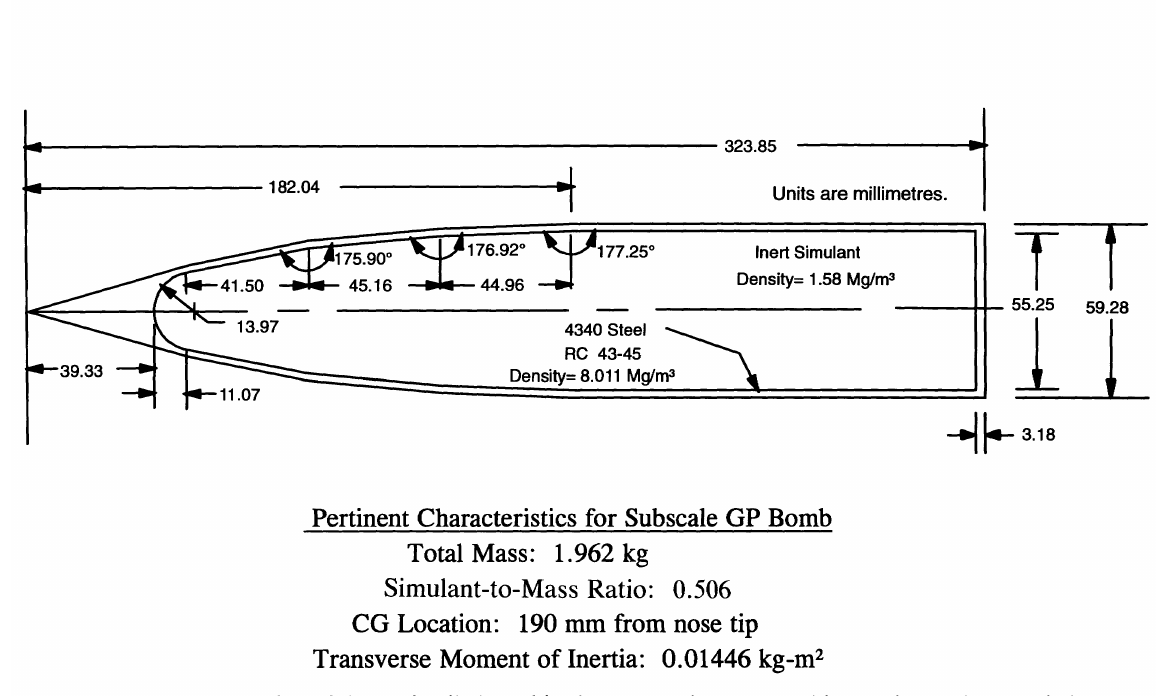
FIGURE 1 Drawing of the projectiled used in the penetration tests and its pertinent